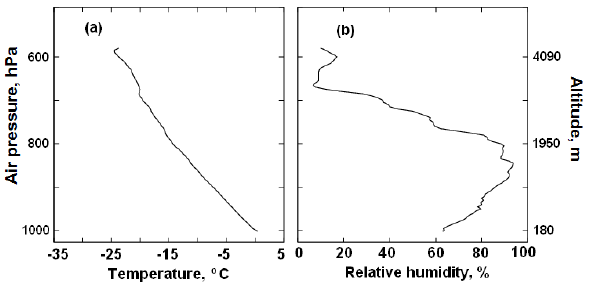
Fig. 6. The mean profiles of air temperature and relative humidity Figure 6: The mean profiles of air temperature and relative humidity obtained from three dropsondes launched during the flight. obtained from three dropsondes launched during the